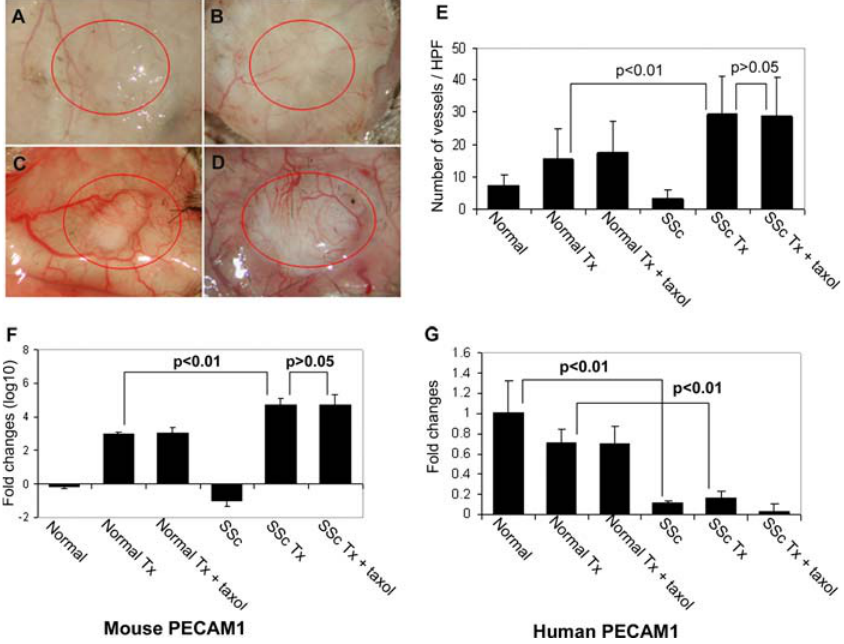
Figure 4. SSc Skin Grafting Stimulates Angiogenesis in SCID Mice Macroscopic analysis of the vessels in the underside of normal (A and B) and SSc (C and D) skin grafts reveals more pronounced angiogenesis in SSc grafts; paclitaxel (Taxol) treatment has no effect on angiogenesis at the macroscopic level (B and D versus A and C). Microscopic analysis shows that the number of vessels in three high-power fields of the SSc grafts is greater than that of normal skin grafts; paclitaxel has no effect on angiogenesis at the microscopic level (E). TRT-PCR for mouse PECAM-1 demonstrates a substantial increase in mouse PECAM-1 mRNA expression in SSc and normal skin grafts regardless of paclitaxel treatment; the amplitude of the increase is significantly greater in SSc than in normal skin grafts (F). Human PECAM-1 is expressed in much lower levels in SSc than in normal skin tissues, indicative of vascular deficiency in SSc; the lack of difference in the expression level of human PECAM-1 in SSc and normal skin tissues before and after transplantation indicates that the neovascular cells are derived from the recipients (G). DOI: 10.1371/journal.pmed.0020354.g004